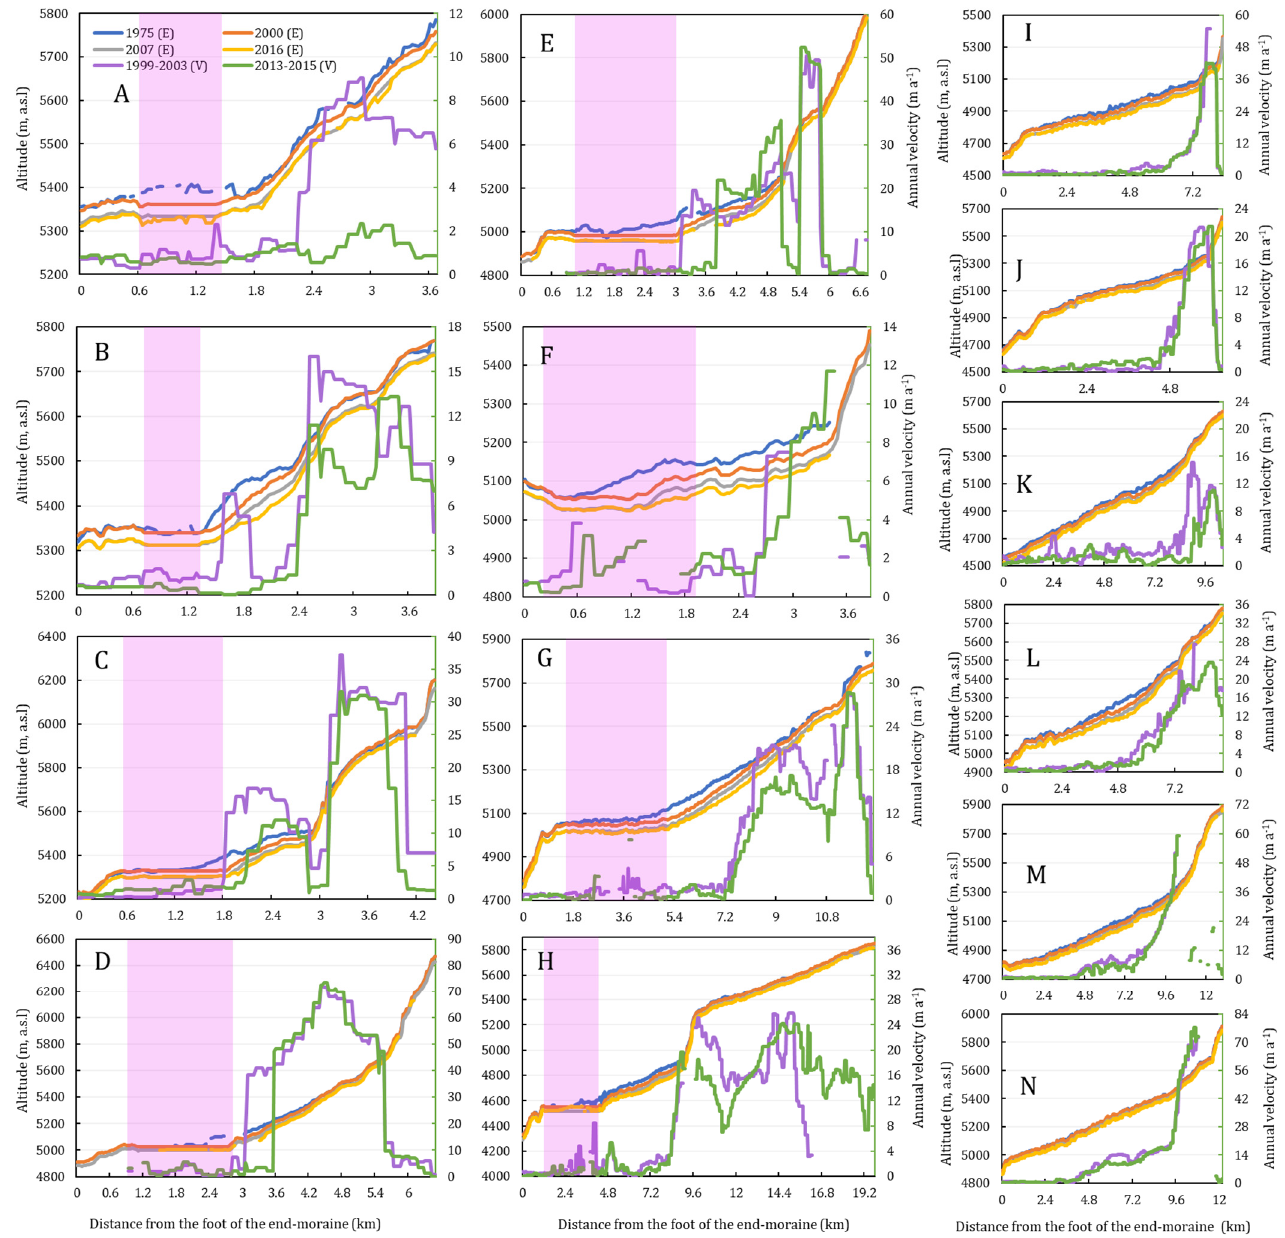
Figure 7. Changes in elevation and velocity of the lake-terminating glaciers ( A – H ) and land-terminating glaciers ( I – N ). “E” is elevation, “V” is velocity, the pink rectangle highlighted is the area where the glacial lake develops.